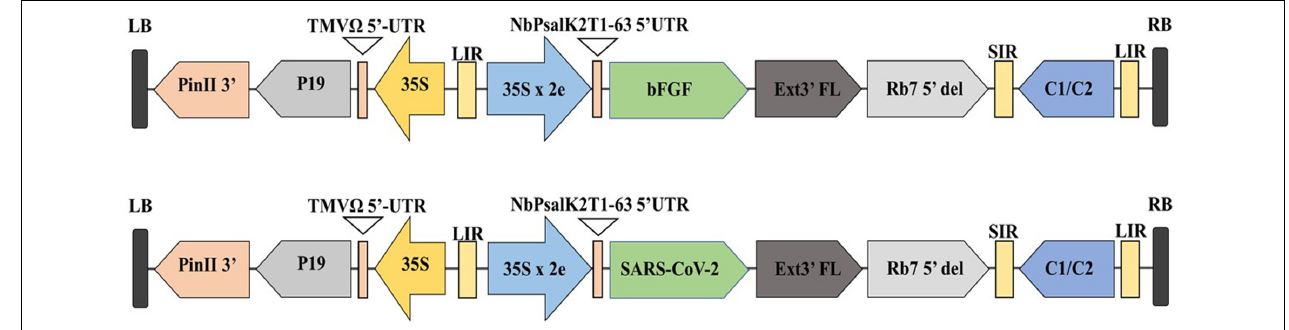
FIGURE 2 | Diagrammatic representation of the T-DNA regions of the expression vector pBYR2eK2Md (pBYR2e). Modified from (Rattanapisit et al., 2020a,b). The bFGF and RBD genes were cloned into geminiviral vector using Xbal and Sad sites. RB and LB: The right and left borders of the T-DNA region in Agrobacterium; P35S: Cauliflower Mosaic Virus (CaMV) 35S promoter; P19: the RNA silencing suppressor from tomato bushy stunt virus (TBSV); NbPsalK2Tl-63 5 (cid:48) UTR: 5 (cid:48) untranslated region; RBD: SARS-CoV-2 RBD; FGF: basic fibroblast growth factor gene; Ext3’FL: 3’ region of tobacco extension gene; Rb7 5 (cid:48) : 5 (cid:48) of the Rb7 matrix attachment region/scaffold attachment region; SIR: short intergenic region of BeYDV: LIR: long intergenic region of BeYDV; C2/C1: Bean Yellow Dwarf Virus (BeYDV) ORFs Cl and C2 encoding for replication initiation protein (Rep) and Rep A: TMVfi 5 (cid:48) -UTR: 5 (cid:48) untranslated region of tobacco mosaic virus (cid:127) ; Pinll 3’: the terminator from potato proteinase inhibitor II